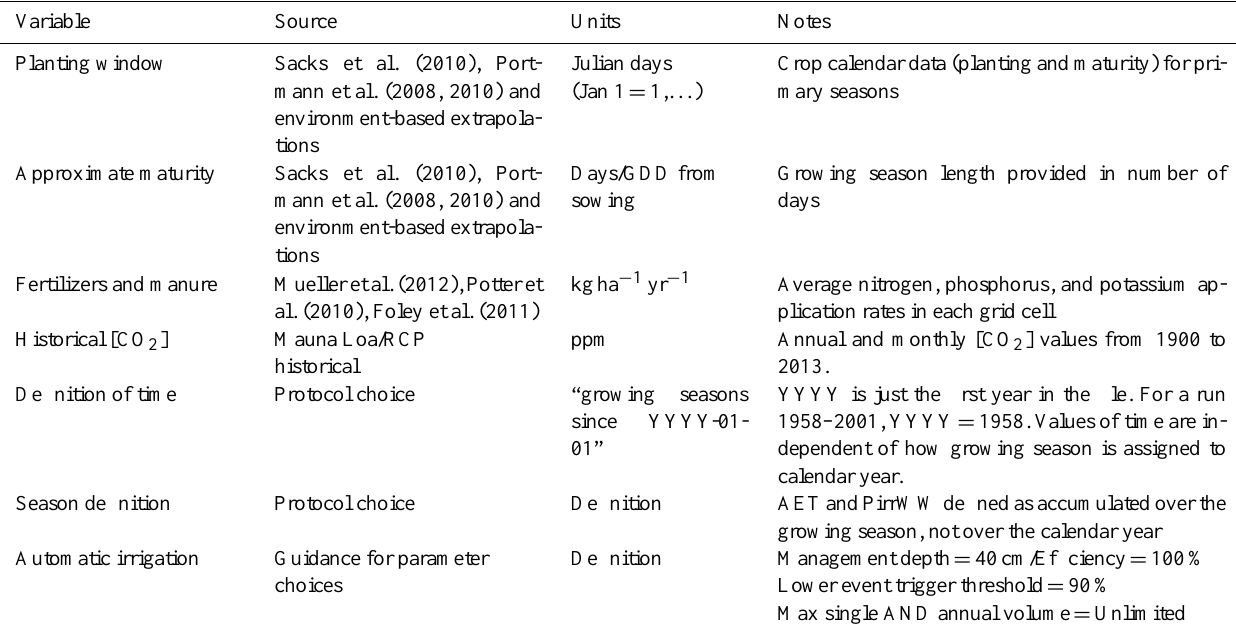
Table 8. Harmonized input variable sources for fullharm and harmnon configurations in Phase